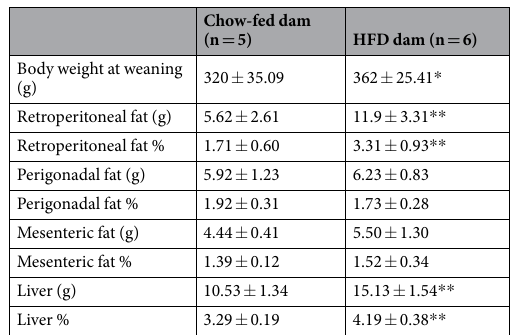
Table 1. Body weight and organ mass of dams fed with Chow or HFD. Results are expressed as means ± SD. Data were analysed by student t-test. * P < 0.05, ** P < 0.01.